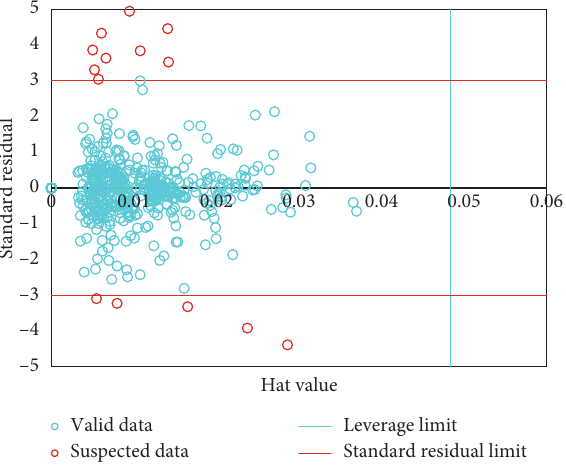
Figure 5: Checking suspected datapoints using the leverage limit